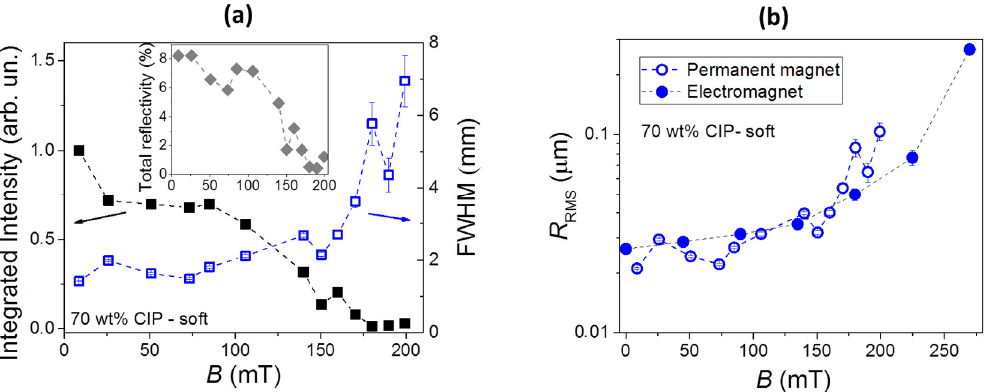
Figure 5. ( a ) Field dependences of the line-integrated intensity (solid symbols) and FWHM (open symbols) of the fitted Gaussian curves (see Figure 4): The inset shows the corresponding total surface reflectivity as a function of magnetic field. ( b ) The RMS surface roughness as a function of the applied magnetic field generated by a permanent magnet (open symbols) and by an electromagnet (solid symbols): The dashed lines are guides for the eye. All data are given for the soft MAE sample with 70 wt% of CIP.